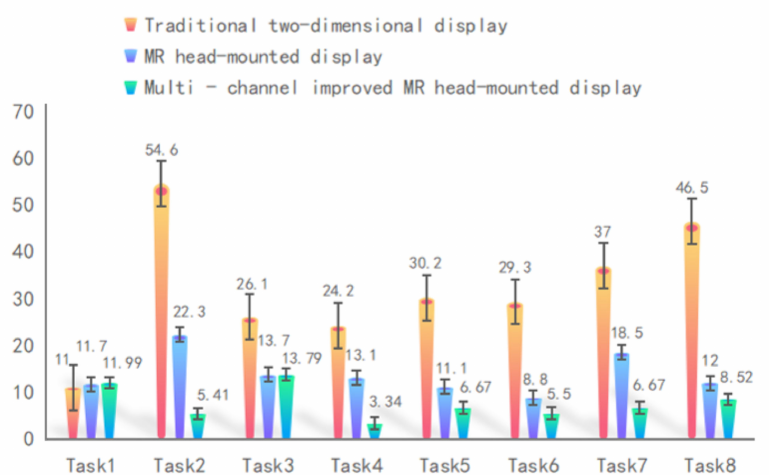
Figure 20. The time taken by the subjects to complete each task in the three display interaction